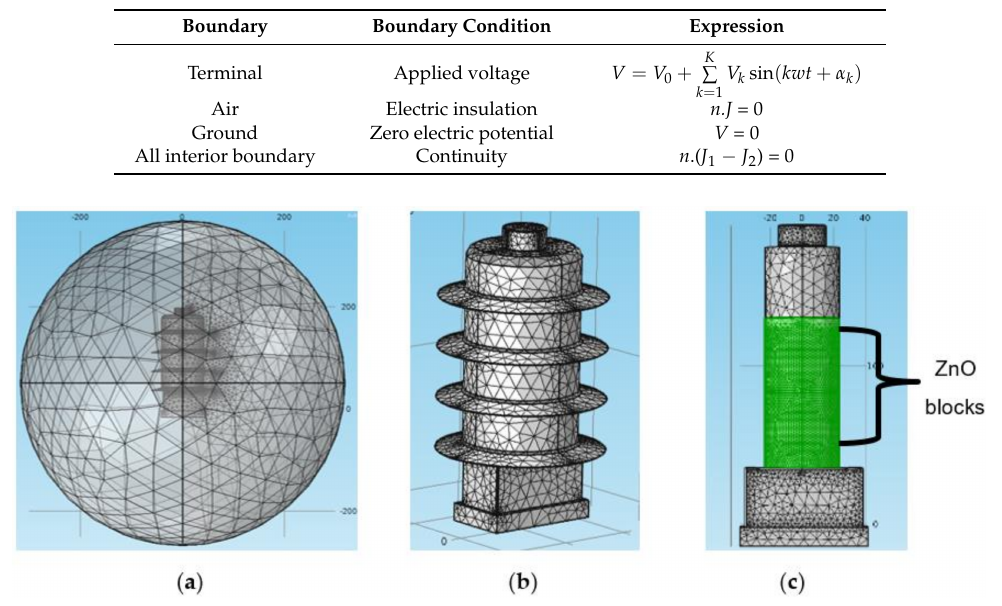
Figure 4. Meshing elements in the model; ( a ) normal elements for air; ( b ) finer elements for all domains of surge arrester; ( c ) extremely fine elements for